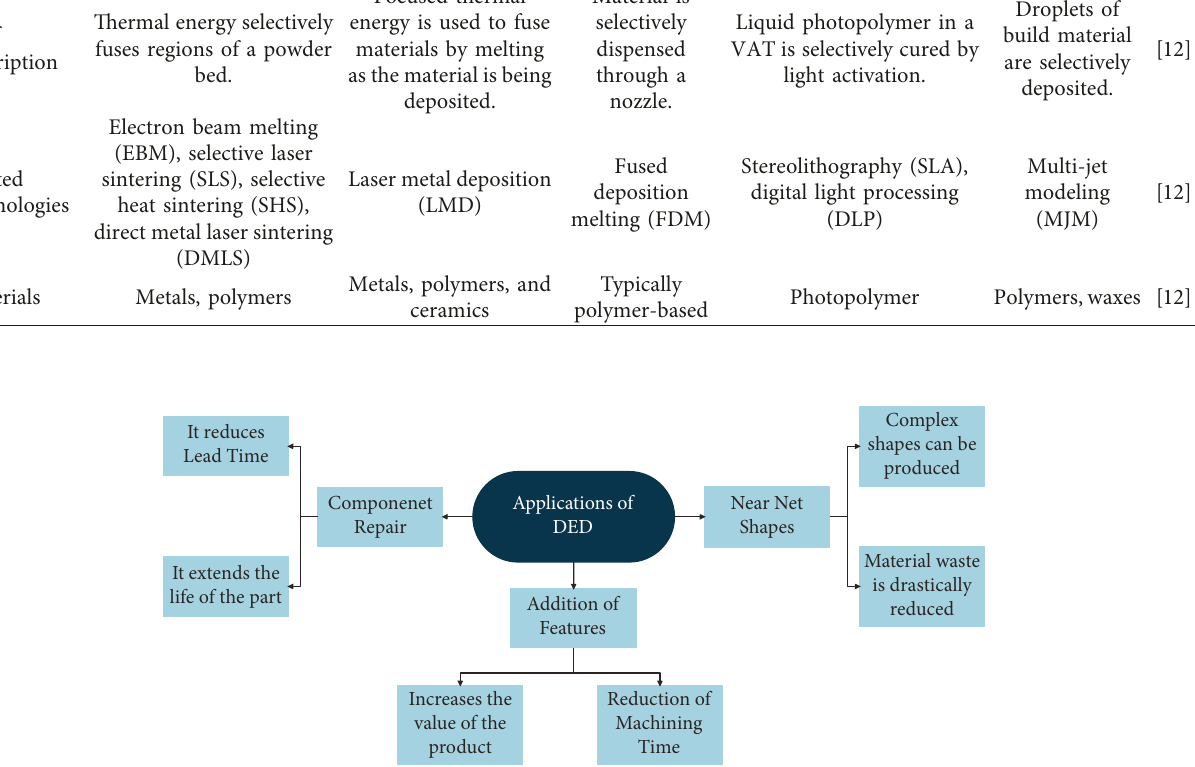
Figure 5: Applications of